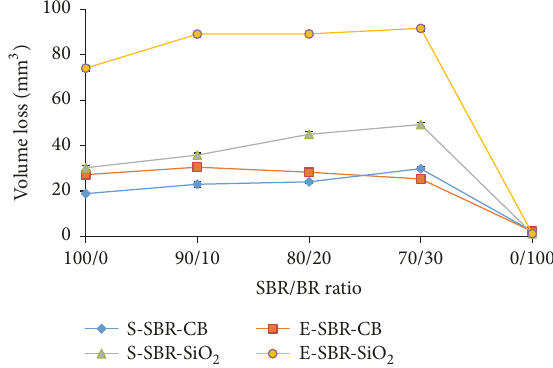
Figure 6: Effect of SBR/BR blend ratio on abrasion